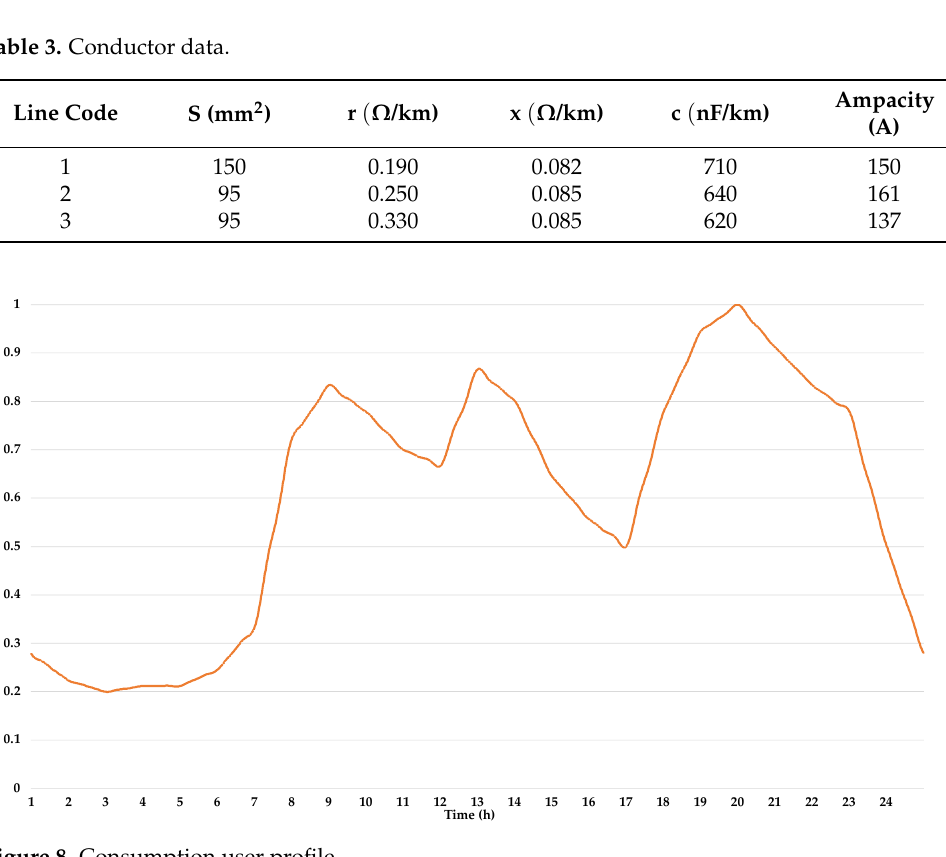
Figure 8. Consumption user profile. Table 1. Load and generation data.